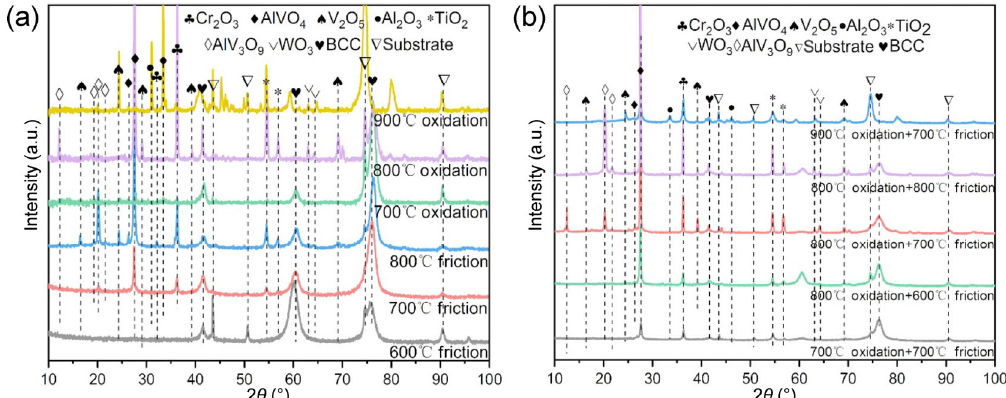
Fig. 5 XRD diffraction patterns of the film after oxidation or friction at different temperatures (a), and after oxidation followed rubbing at different temperatures (b).